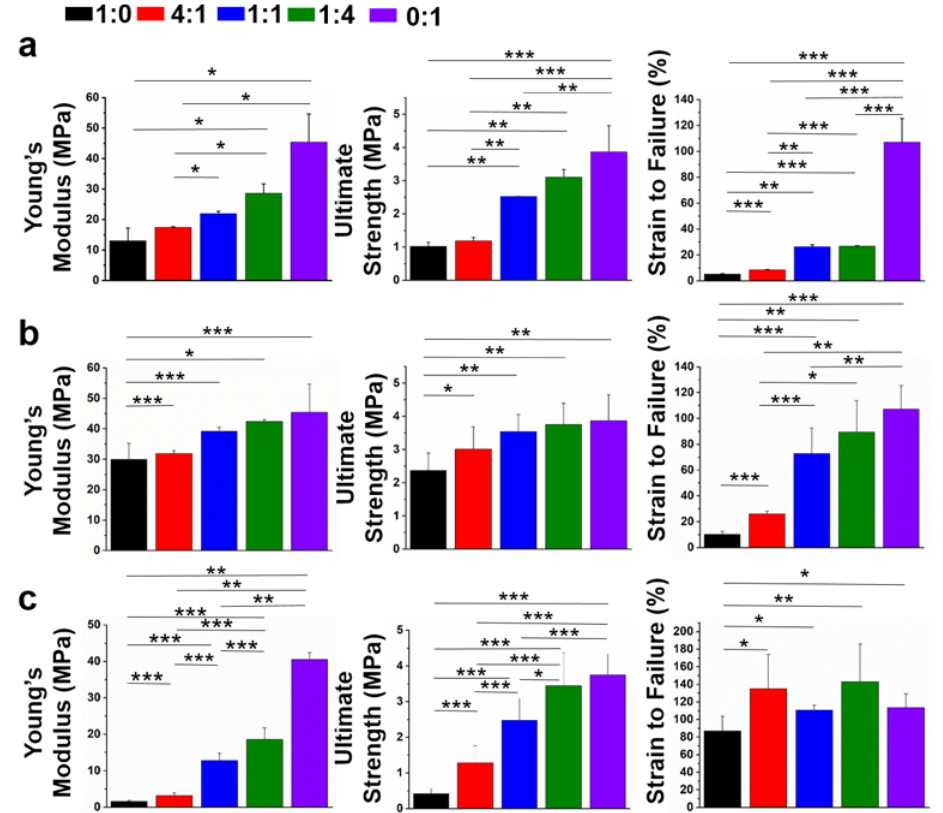
Figure 6. ( a ) The mechanical properties of un ‐ crosslinked nanofiber mats with different MeGel/PLLA mass ratios (n = 5; *p < 0.05, **p < 0.01, ***p < 0.001). The mechanical properties of crosslinked nanofiber mats with different MeGel/PLLA mass ratios in ( b ) the dry condition dry and ( c ) the wet condition (n = 5; *p < 0.05, **p < 0.01, ***p < 0.001).